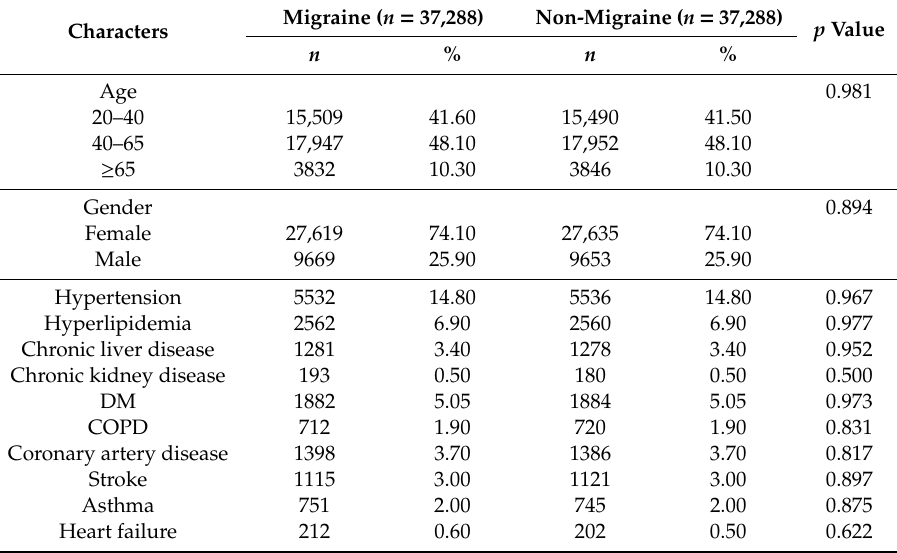
Figure 1. The flowchart of patient selection. n : Number; PAOD: Peripheral artery occlusive disease; # include age, gender, hypertension, hyperlipidemia, chronic liver disease, chronic kidney disease, diabetes, chronic obstructive pulmonary disease, coronary artery disease, stroke, asthma, and heart failure. Table 1. Basic characteristics of migraine and non-migraine.